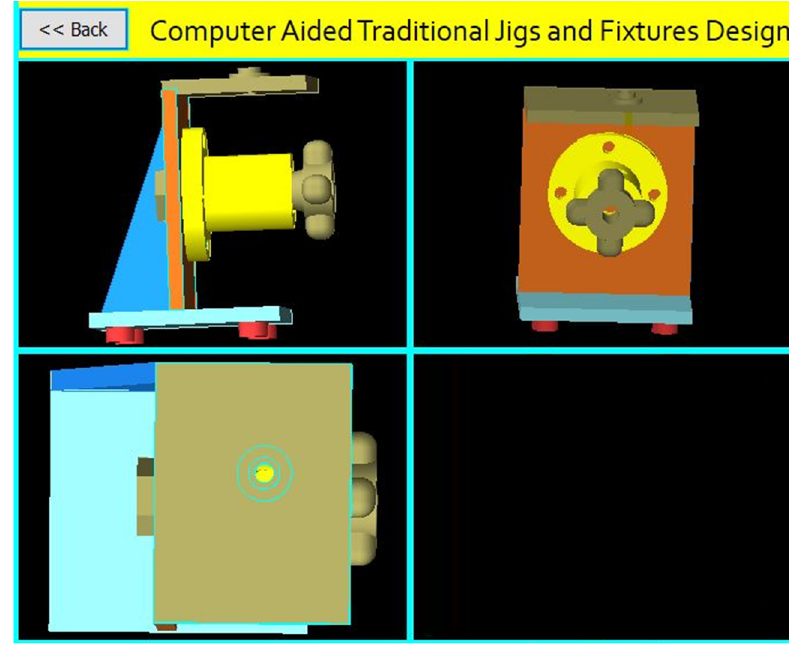
Figure 28. The jig views. A Jig Design for a Cylindrical Part with an Inclined Cross Blind Hole.